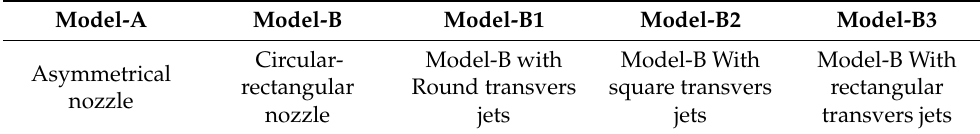
Figure 1. Physical models of CASEs. Table 1. Illustration of the